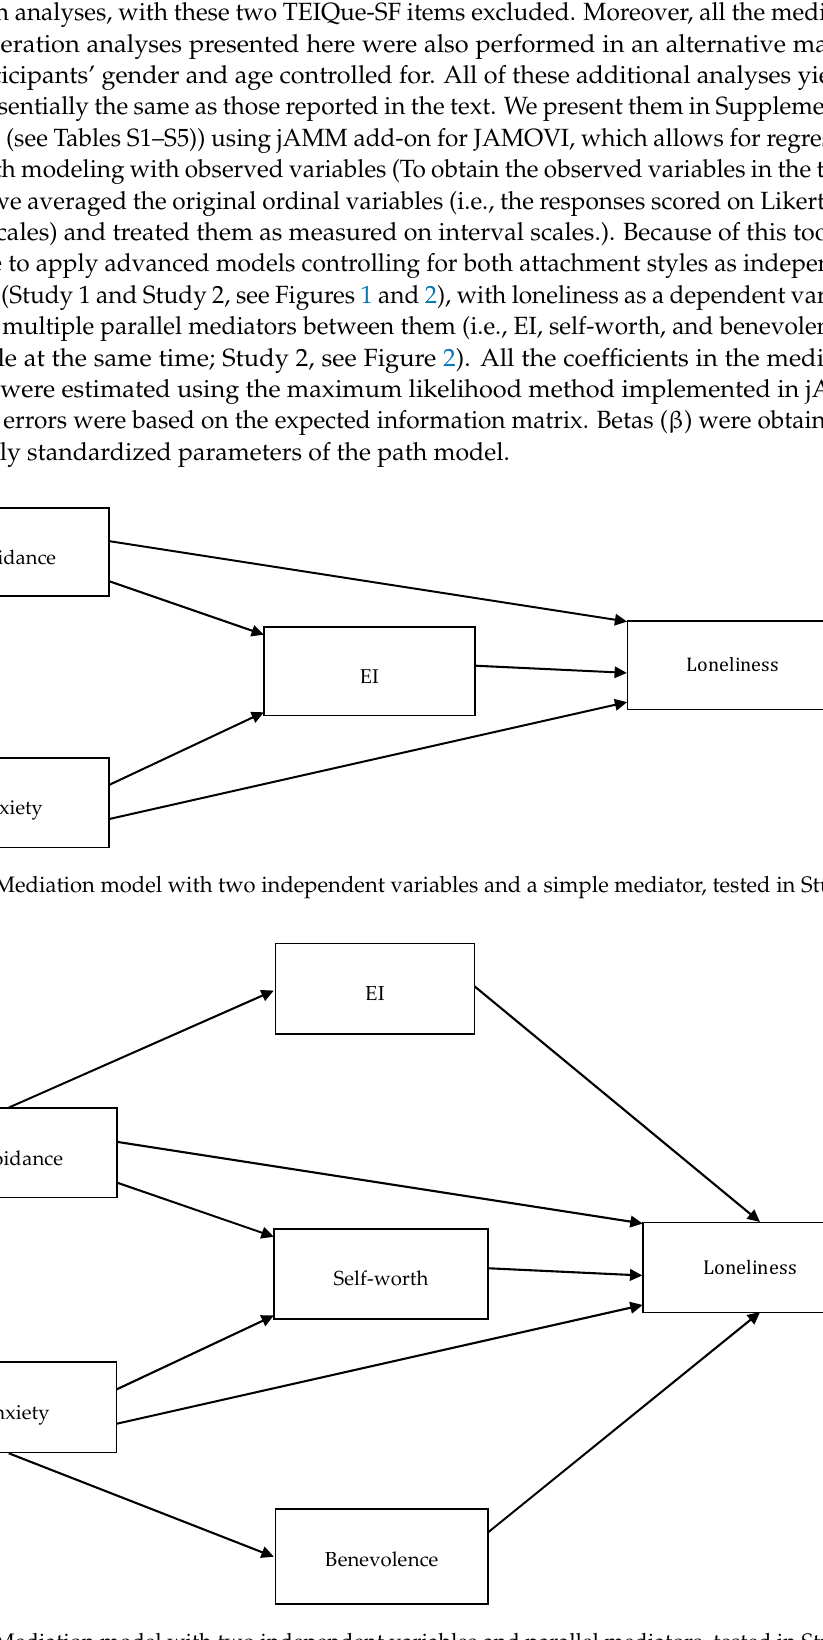
Figure 2. Mediation model with two independent variables and parallel mediators, tested in Study 2.